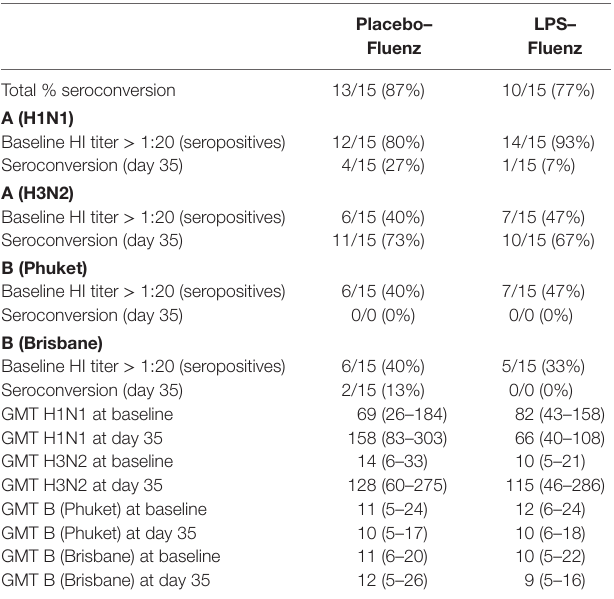
Table 2 | Results of the hemagglutination inhibition (HI) assay for the various influenza strains present in the vaccine in the 26 subjects who were challenged with lipopolysaccharide (LPS) ( n = 13) or placebo ( n = 13) on day 0 and were inoculated with Fluenz on day 7.